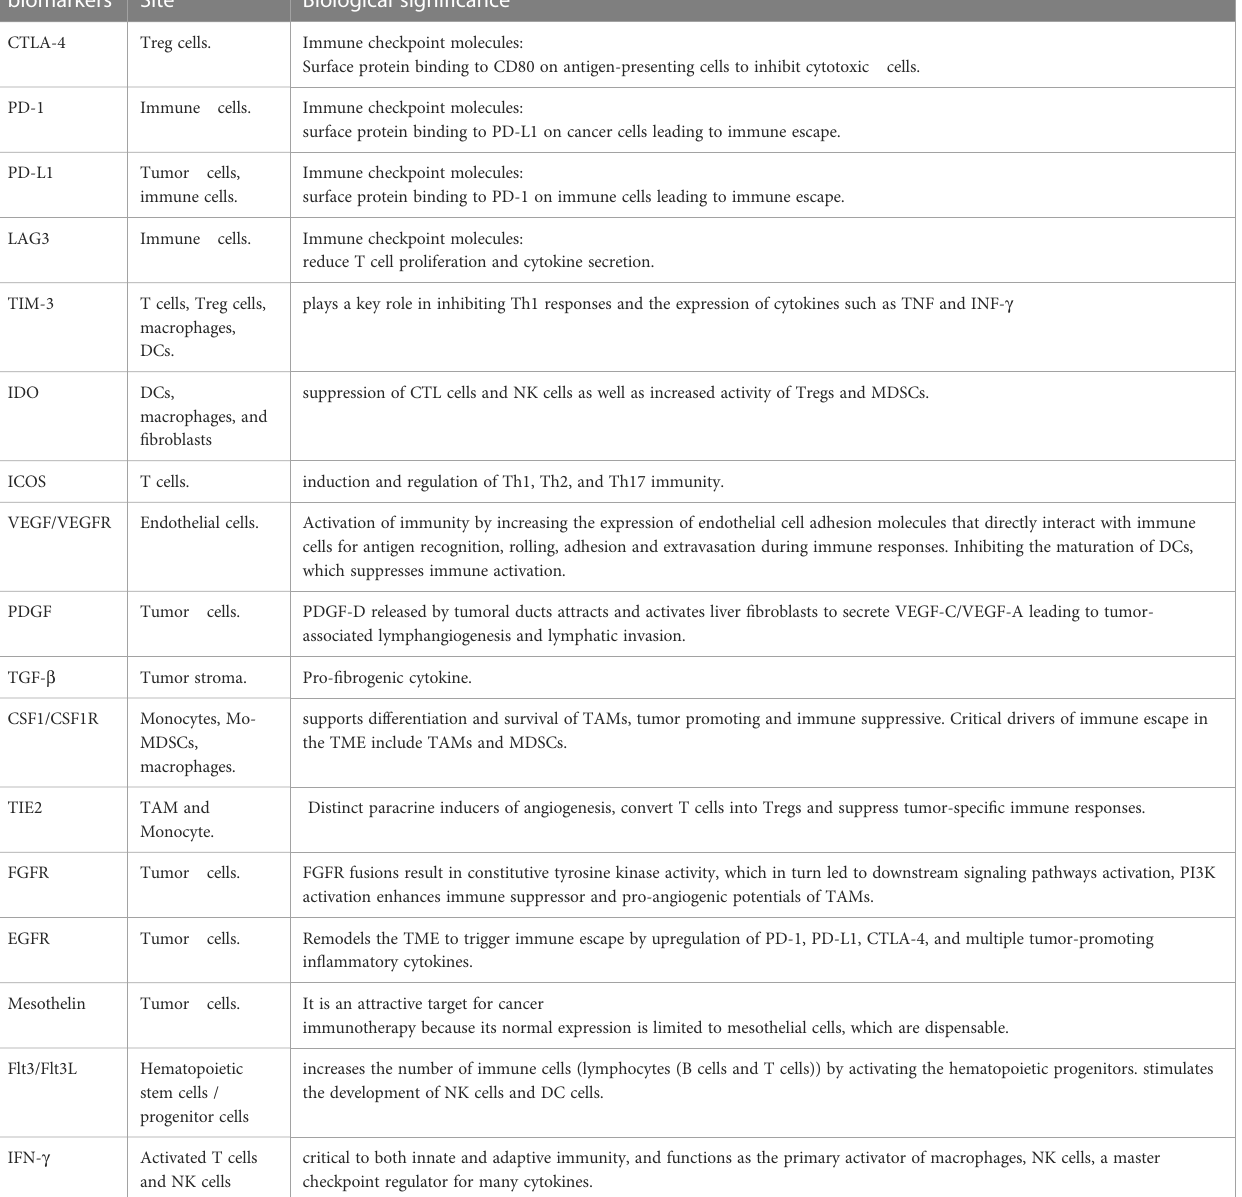
TABLE 3 Immune-related biomarkers in microenvironment and clinical molecular target in CCA.